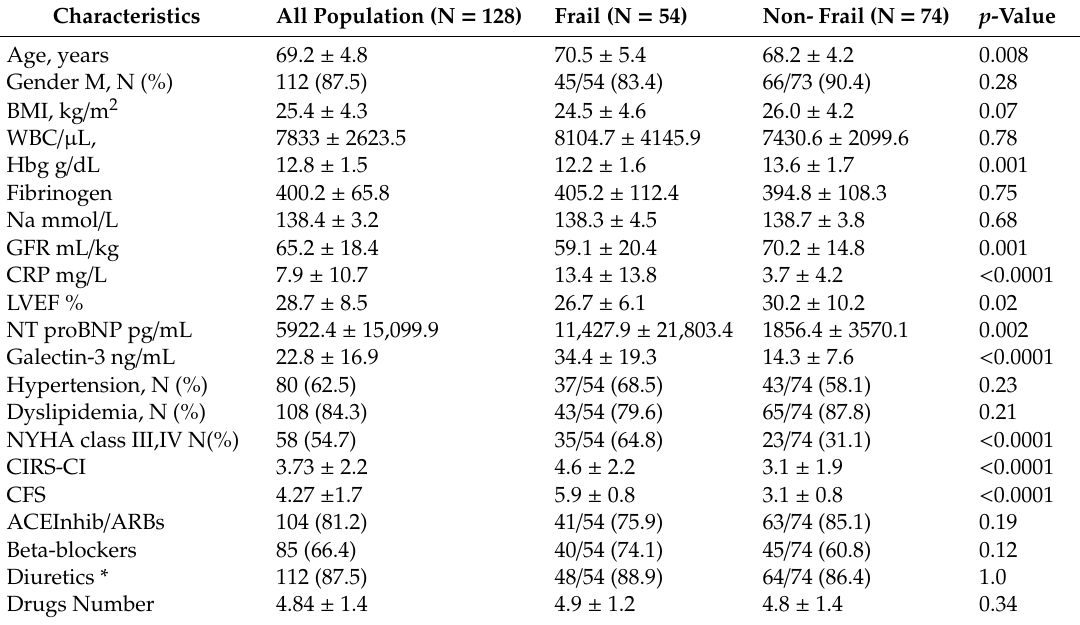
Table 1. Characteristics of patients in the overall study population, stratified as frail and non-frail.